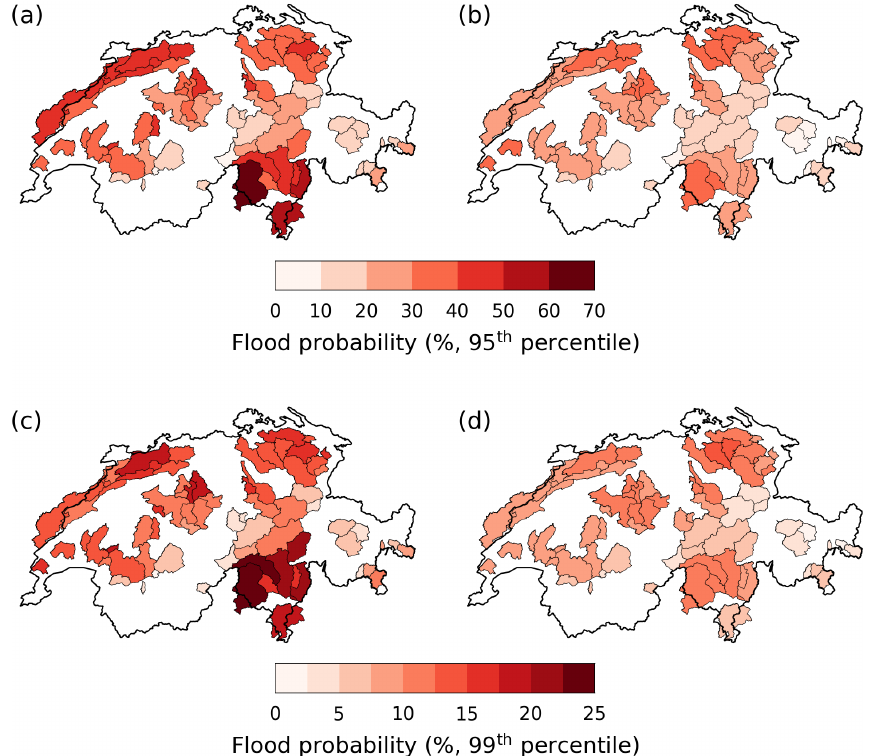
Figure 10. (a, b) Fraction of days with discharge above its 95th percentile in the 5d following (a) an extreme precipitation event that is part of a 21d cluster and (b) any random precipitation extreme. (c, d) Same as (a, b) but for the 99th daily discharge percentile.